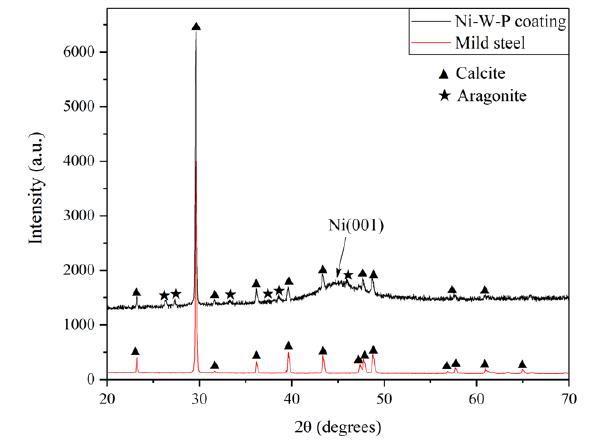
ff raction pattern of the fouling on specimen Figure 8. X-ray diffraction pattern of the fouling on specimen surfaces. Figure 8. X-ray di Figure 8. X-ray diffraction pattern of the fouling on specimen surfaces.